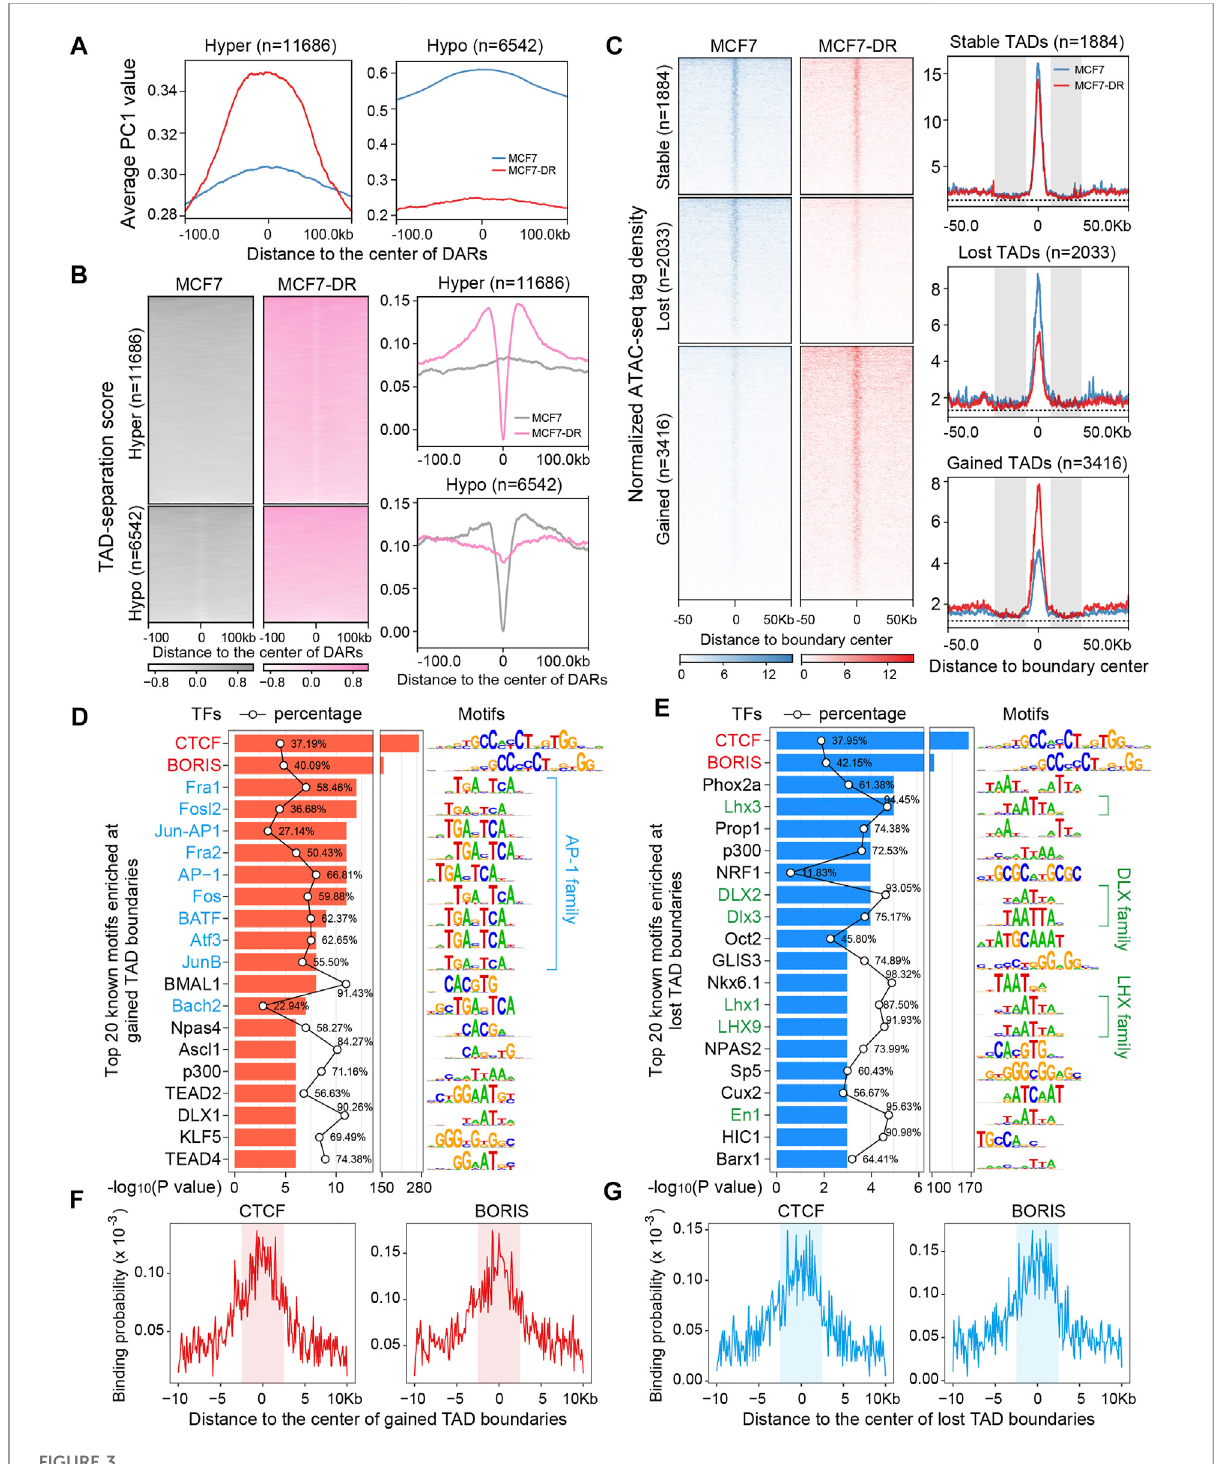
FIGURE 3 Differential chromatin accessibility and transcription factor families contribute to the formation of TAD boundaries. (A) Pro fi les depicting the distribution of average PC1 values (at 20-kb resolution) identi fi ed by the HOMER software (v4.10) surrounding the center of 11686 hyper- and 6542 hypo-accessible regions across a genomic window of ±100 kb in MCF7-DR cells compared to MCF7 cells. DARs, differentially accessible regions. (B) Heatmaps and average pro fi les of TAD-separation scores surrounding the center of 11686 hyper- (top panel) and 6542 hypo- accessible (bottom panel) regions across a genomic window of ±100 kb in MCF7-DR cells compared to MCF7 cells. (C) Heatmaps and pro fi les showing thenormalized ATAC-seq tag density surroundingthe centerof thestable ( n = 1884), lost( n = 2033) and gained( n = 3416)